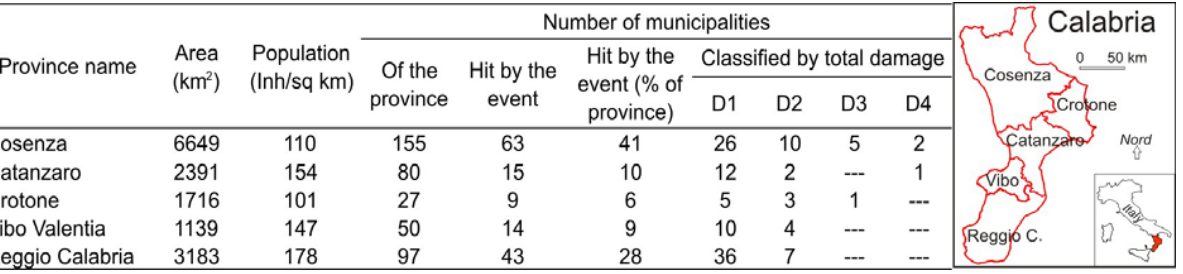
Table 1. Main characteristics of Calabria provinces (Area, Population, and Number of municipalities of the province). The impact of the 2009 landsliding event for each province is expressed by the number of municipalities damaged (either as the amount or percentage of the municipalities of the province that were damaged) and the total number of municipalities affected, which were divided into four classes according to the total cost of the landslide damage (D1, D2, D3 and D4). On the right, the map shows the Calabria region. Table.